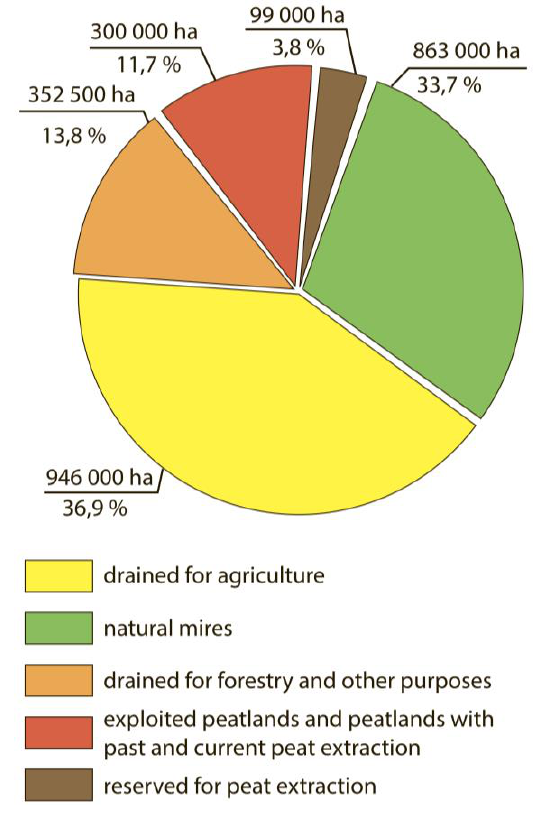
Figure 3. Protection status of the 863,000 ha of natural mires in